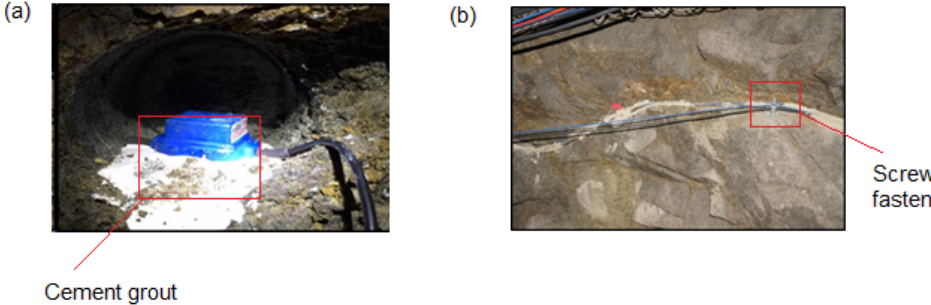
Figure 16. ( a ) Cement-based grout is used to couple a single-component geophone with the rock, and ( b ) the fiber-optic cables are coupled with the mine wall using a metal screw mounted fastener